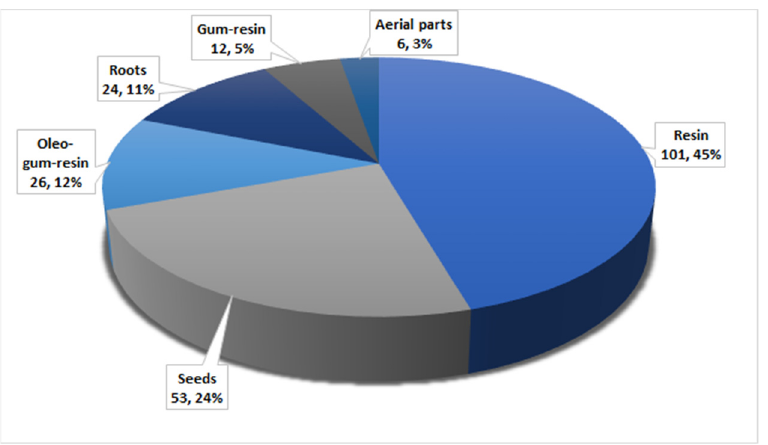
Figure 21. Number of compounds and their percentage reported from various parts of F. sinkiangensis .